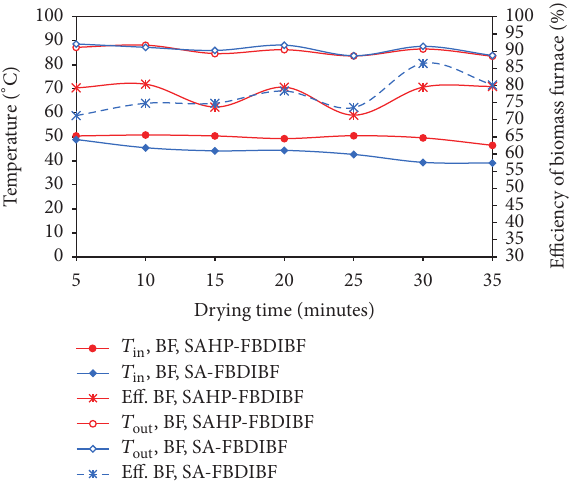
Figure 14: The variation of relative humidity with drying time.